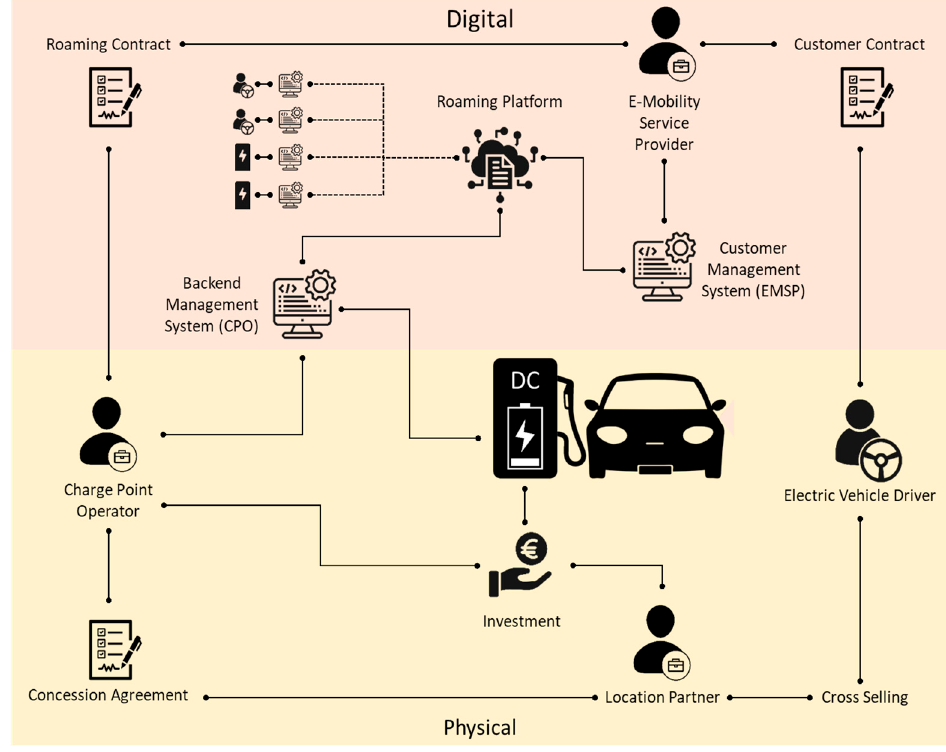
Figure 1. Actors involved in electric vehicle (EV) charging processes (own diagram based on [9]).